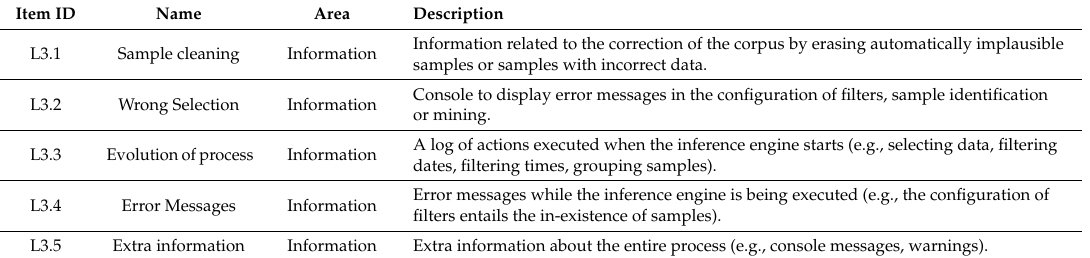
Table 3. Structure and items of the information area in the process mining dashboard under